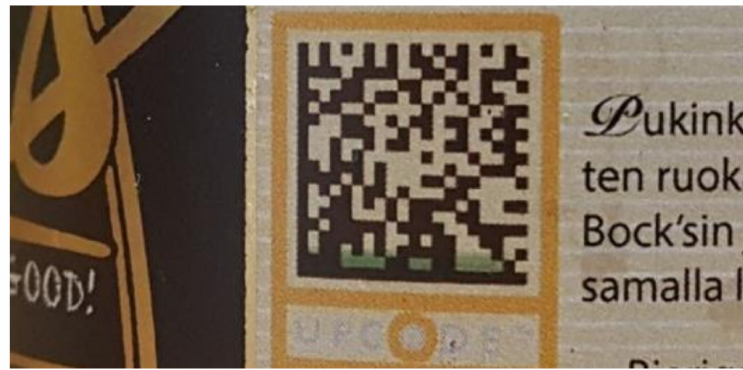
Figure 13. SmartTag with reversible thermochromic sensors used in the